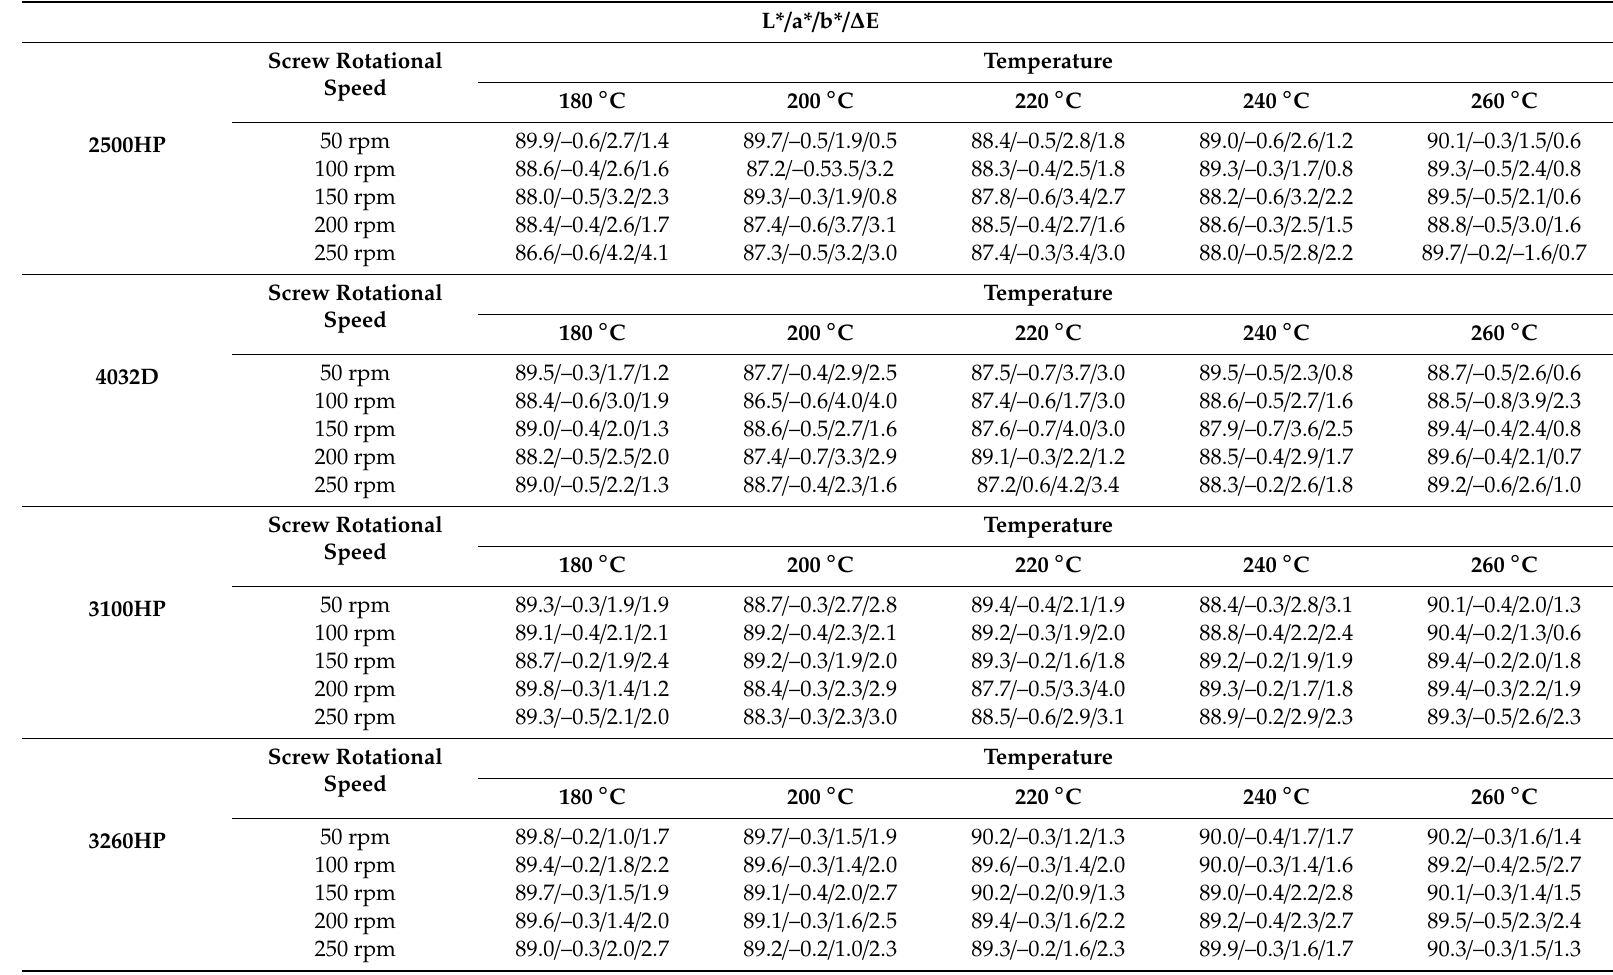
Table 6. L*, a*, b* and ∆ E color parameters obtained for PLAs under various processing